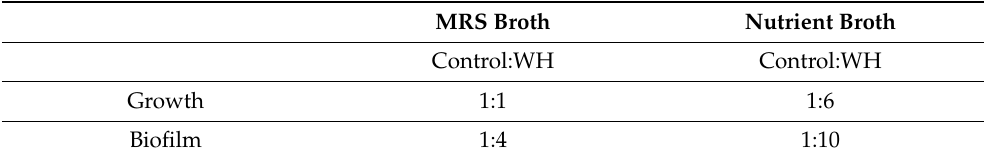
Table 1. Summary of the approximate ratio of L. plantarum cells grown in the presence of whISOBAX (WH) or ethanol (control) in each broth tested (nutrient broth (Nut) or MRS broth).